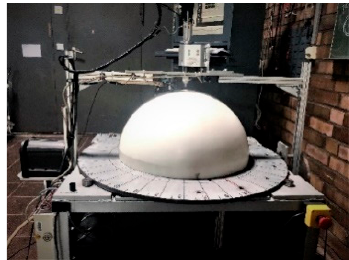
Figure 8. Polyamide half sphere test specimen with automatic ball scanner.